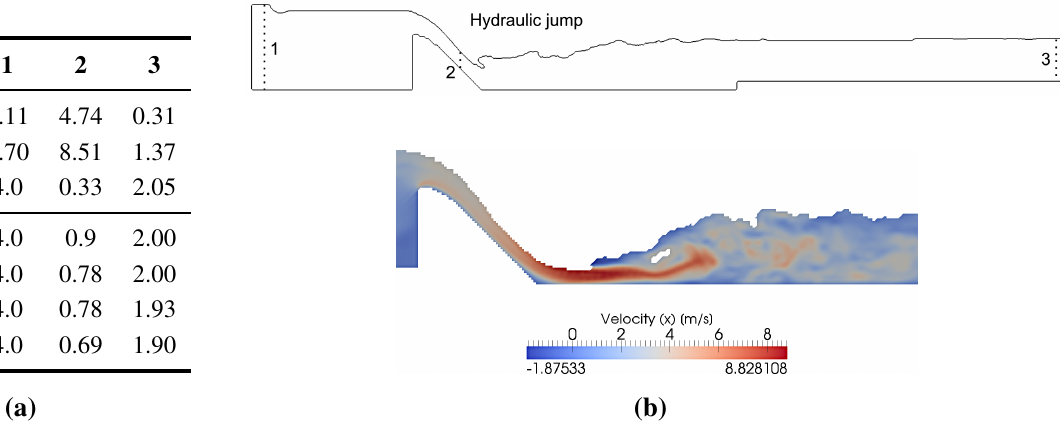
Figure 22. Results for the flow past a weir (GPU simulation). ( a ) Bernoulli predictions (top) vs. ELBE results (bottom); ( b ) slices with Sections 1–3 and the velocity profile for a grid spacing ∆ x = 0 . 067